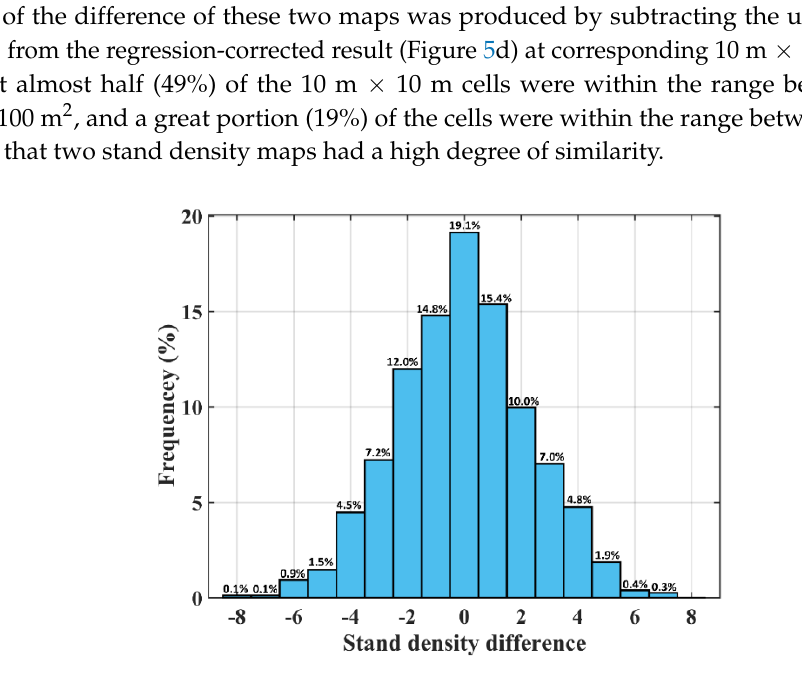
Figure 6. Frequency distribution histogram of the difference in stand density; subtract Figure 5c from Figure 5d.